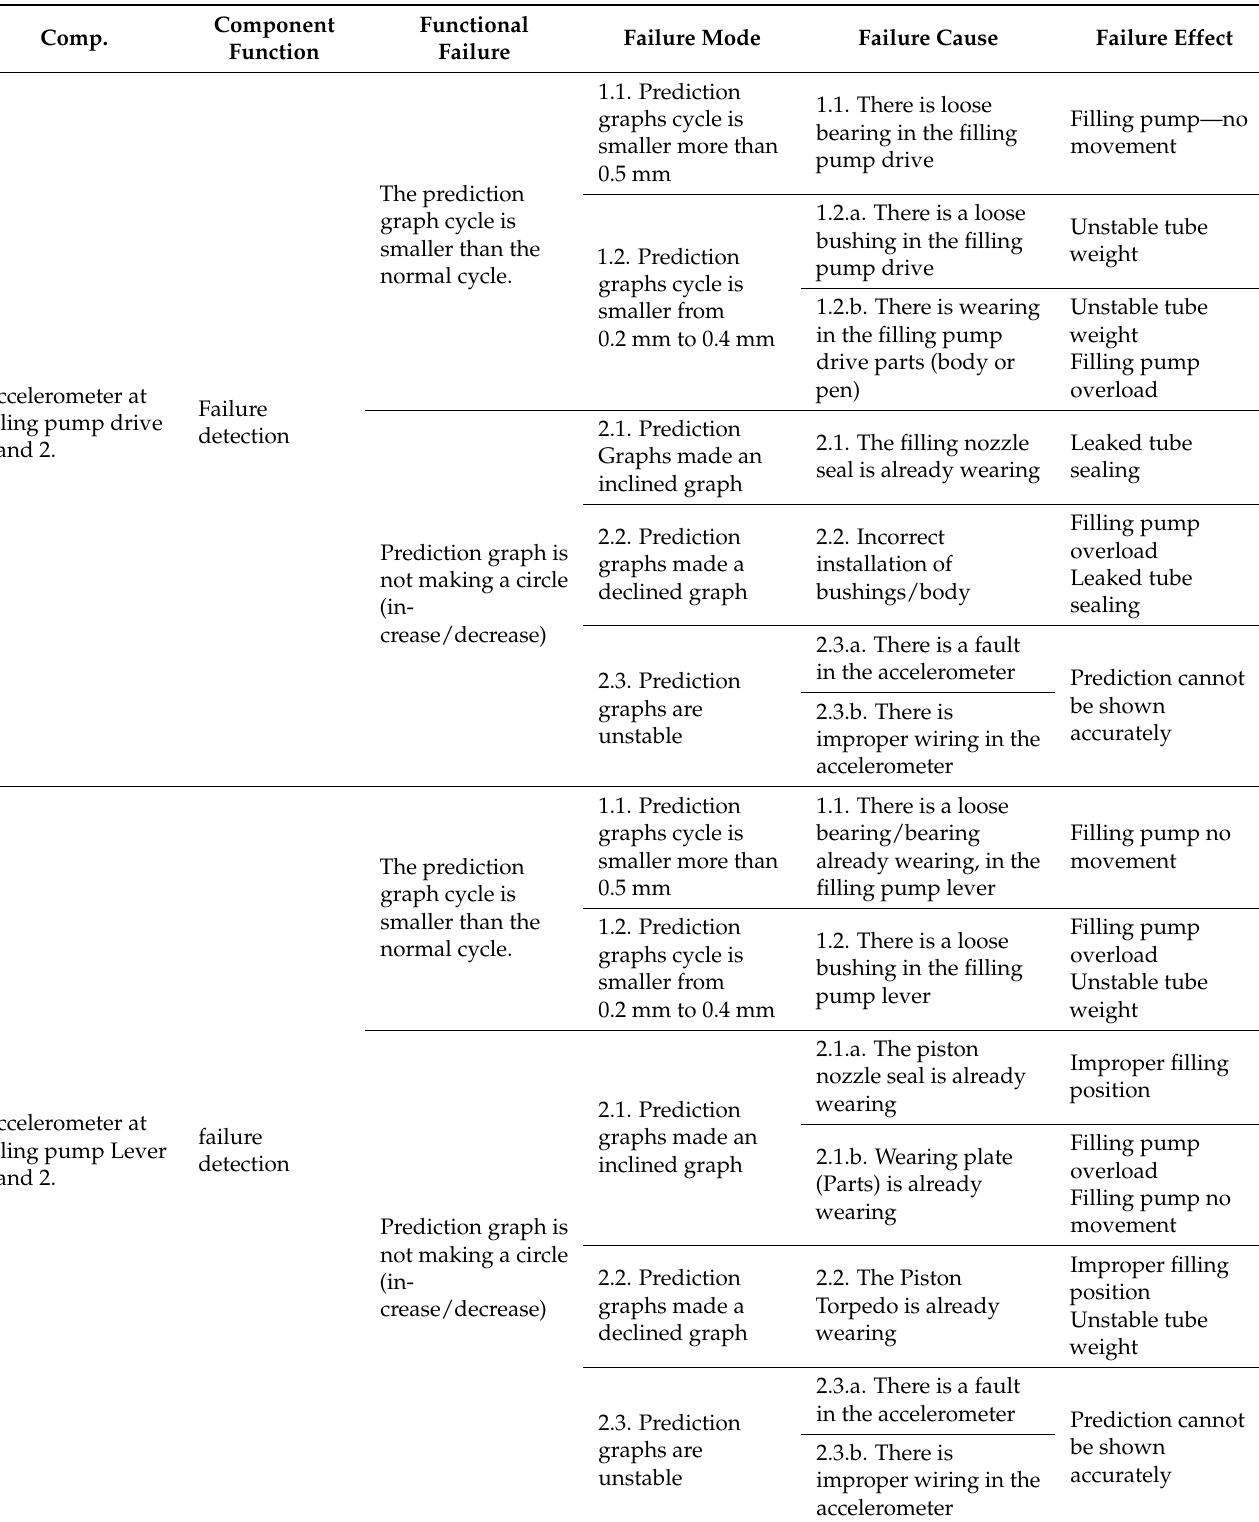
Table 9. FMEA of the prediction of system